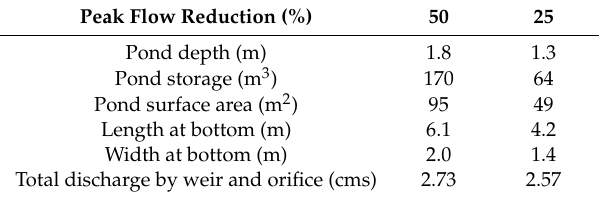
Figure 18. Inflow and outflow hydrograph for ( a ) 25 percent peak flow reduction and ( b ) 50 percent peak flow reduction. Table 8. Summary for two different scenarios (50 and 25 percent peak flow reduction).